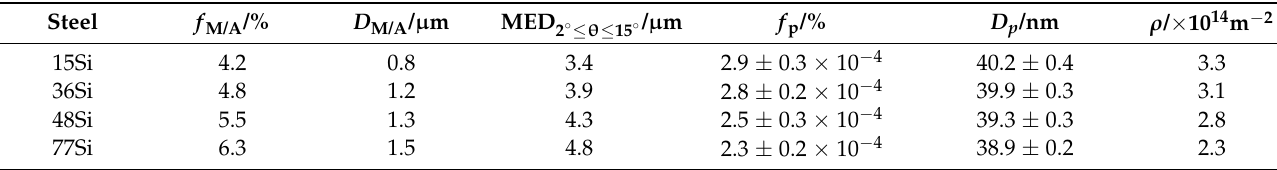
Table 3. Microstructure